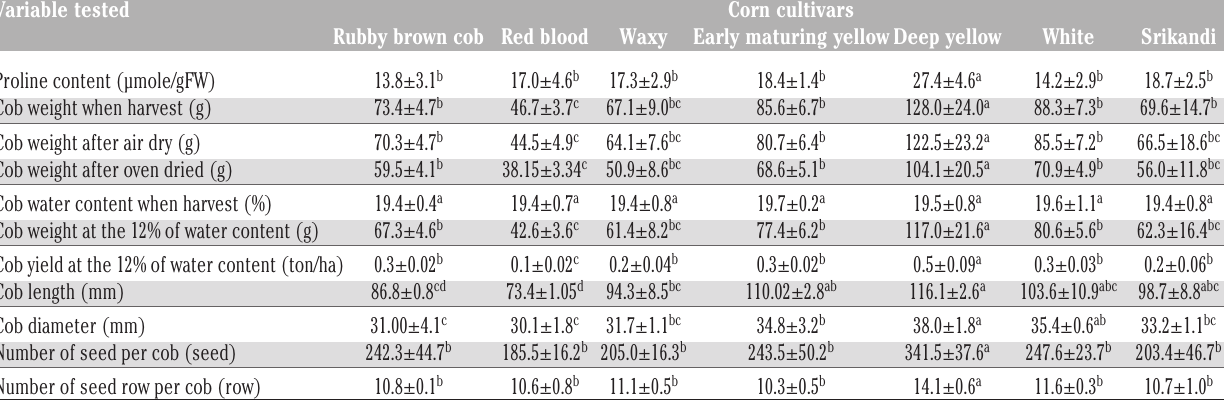
Table 1. Proline content and yield components of corn from Kisar Island Maluku (Indonesia). Variable